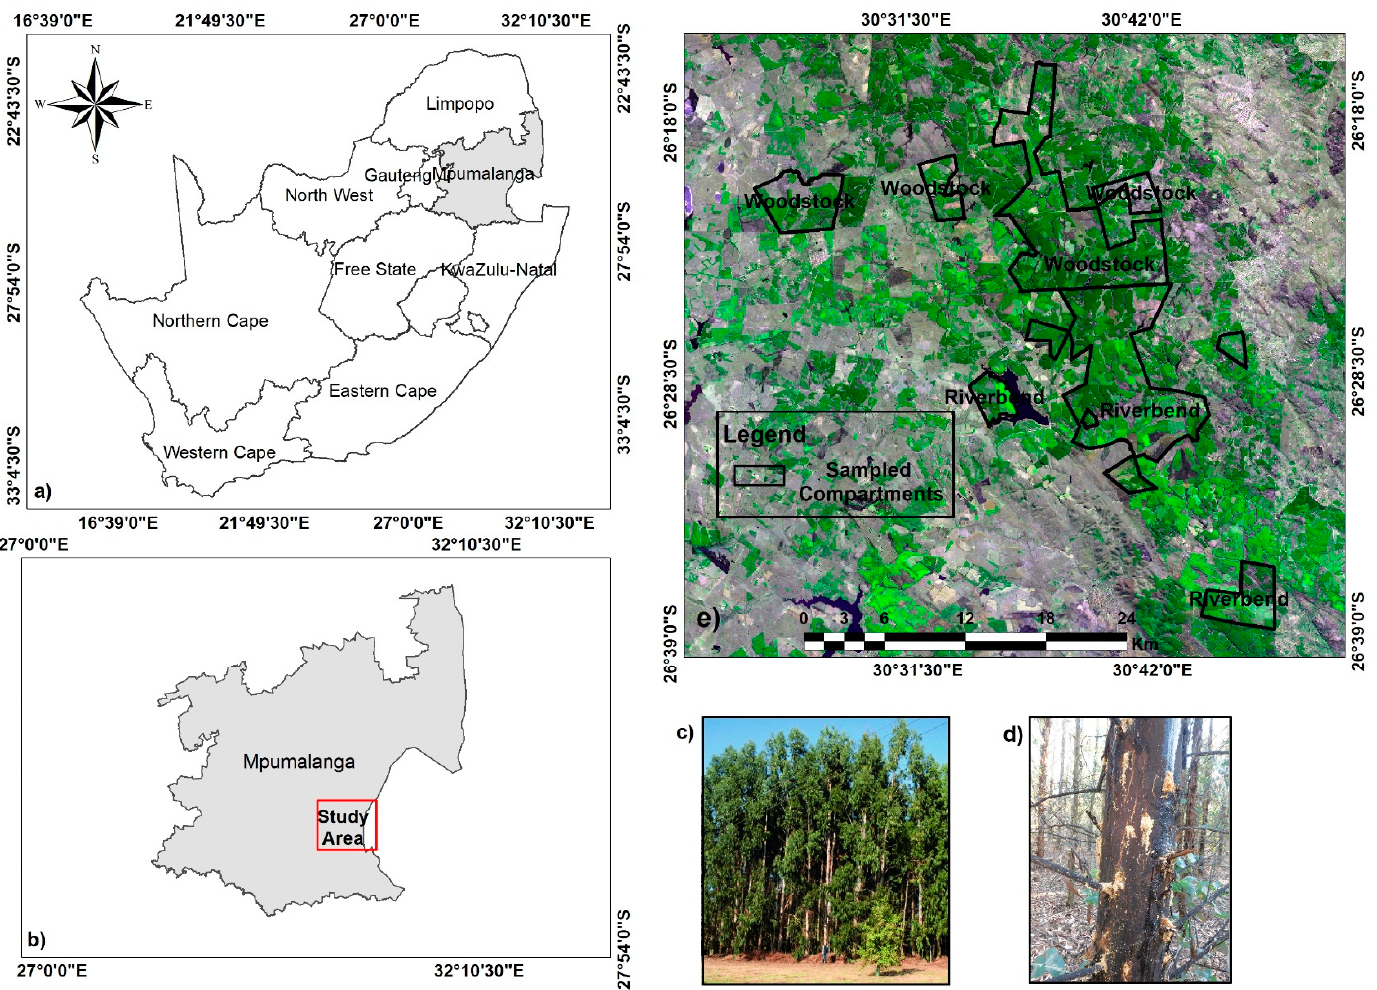
Figure 1. ( a ) Map of South Africa showing the Mpumalanga Province, ( b ) the location of the study area within the Mpumalanga Province ( c , d ) show healthy and infested Eucalyptus nitens and ( e ) shows the sampled compartments over the Sentinel-2 image with a false-colour composite of R-NIR-B (B4, B8 & B2).